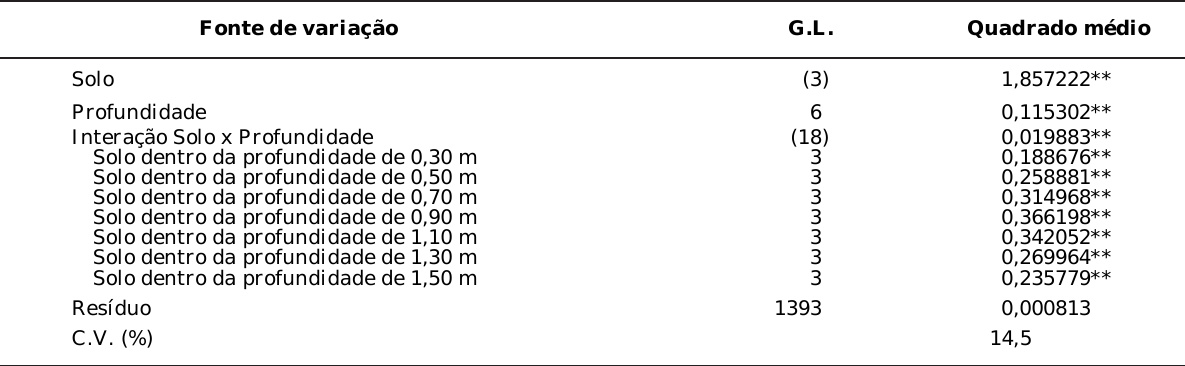
**: Significativo a 1